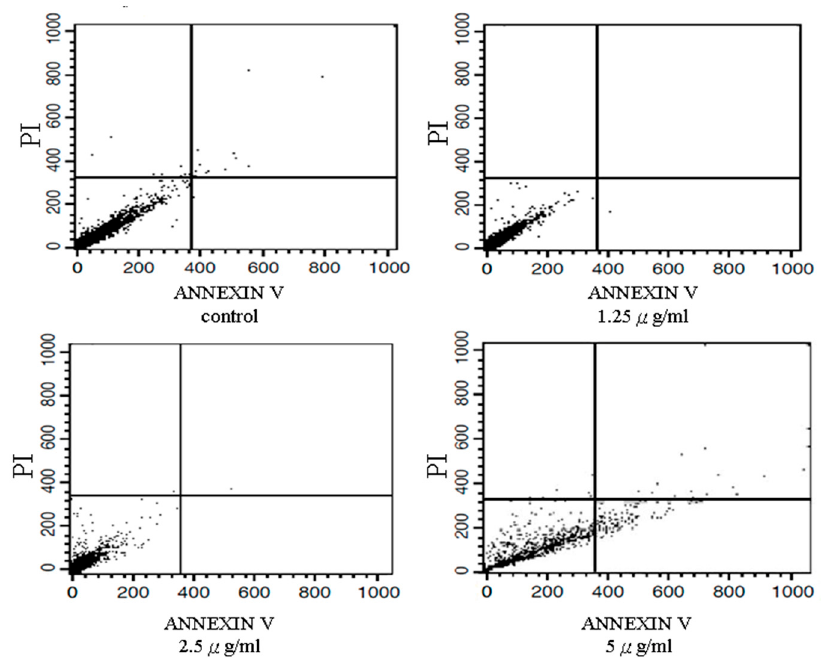
Figure 2. Results of flow cytometric analyses. Effects of tagitinin C on apoptosis in a hepatoma cell line. Huh 7 cells (8 × 10 5 cells/mL), treated with or without tagitinin C for 24 h, were harvested and fixed with 1 mL of ice-cold 70% ethanol at 4 °C for 2 h. Annexin V is a phospholipid-binding protein that has affinity for phosphatidylserine (PS) and is used to analyze apoptotic activity. Test cells were stained using an Annexin V-FITC assay kit (Dojindo, FoliBio Technology Co., Ltd., Taipei, Taiwan) for 15 min and then treated with propidium iodide (PI) for 30 min in the dark. The apoptotic cell distribution was analyzed by fluorescence-activated cell sorting flow cytometry (BD FACSCalibur™ Flow Cytometer; BD Biosciences).